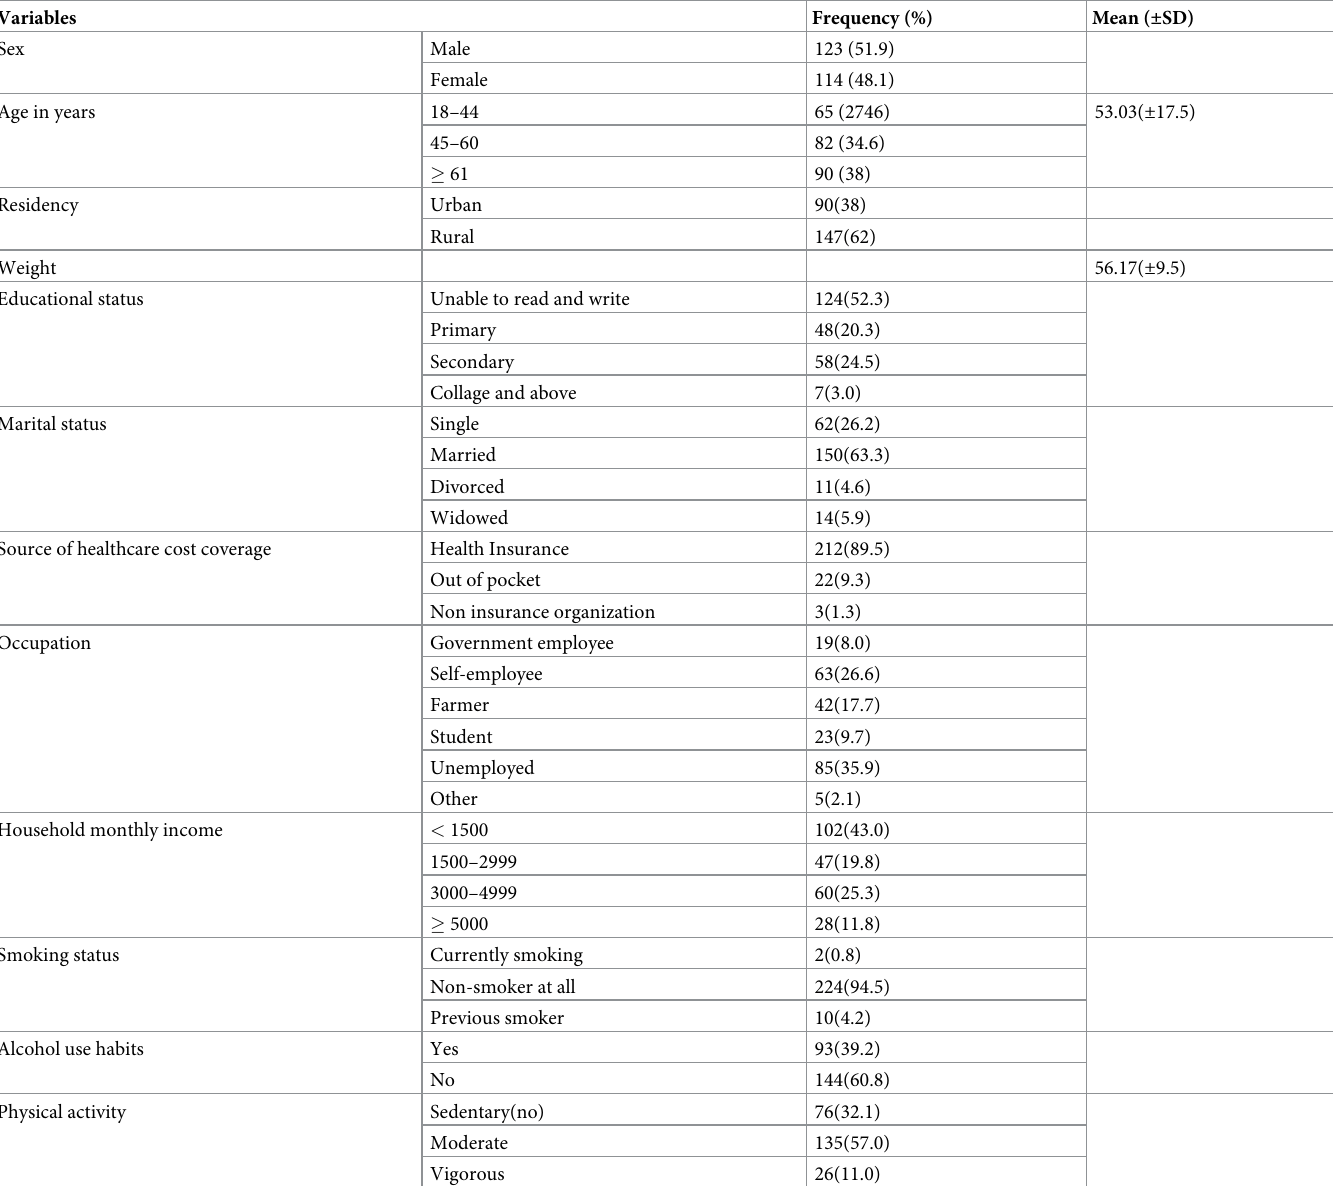
Table 1. Sociodemographic characteristics of hospitalized patients in the UoGCSH medical ward from May 28 to July 26, 2022 (N = 237).